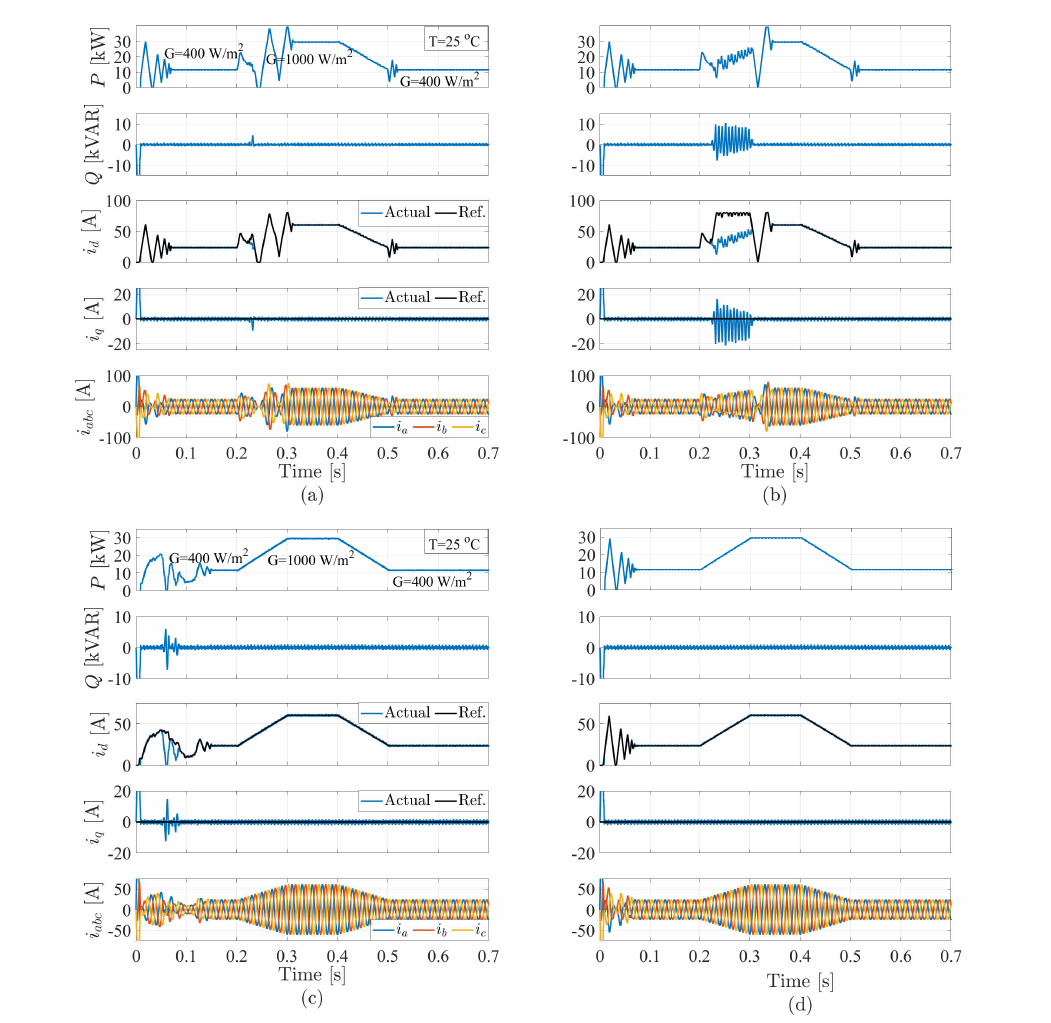
Figure 16. Grid-connected inverter behavior with a gradual change of radiation (from top): Grid-injected active power, reactive power, d -axis current, q -axis current, and the abc currents for: ( a ) P&O method; ( b ) modified P&O; ( c ) multi-power-sample method; ( d ) the proposed model-based